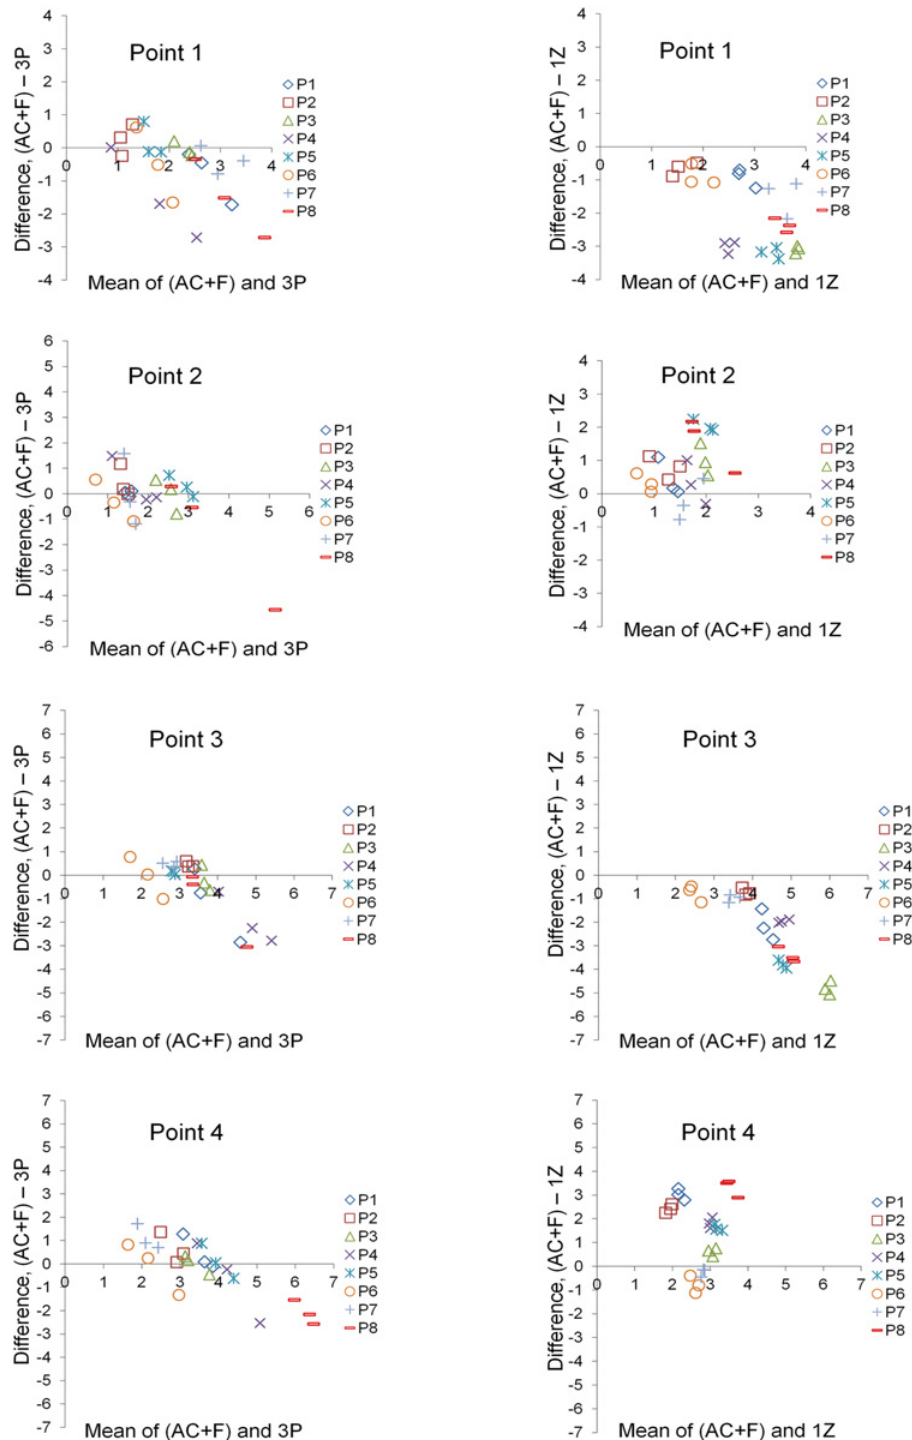
Fig 7. Differences of the 3P and 1Z superimposition techniques from the gold standard technique. Bland-Altman plots of differences of the three-point (3P) or one zygomatic arch (1Z) superimposition techniques from the gold standard superimposition technique (anterior cranial base + foramen magnum: AC +F). These consider the measured structural changes induced by treatment at four specific points of interest, measured by each operator, for all eight patients (P). The axes length represents the true range of observed values of structural